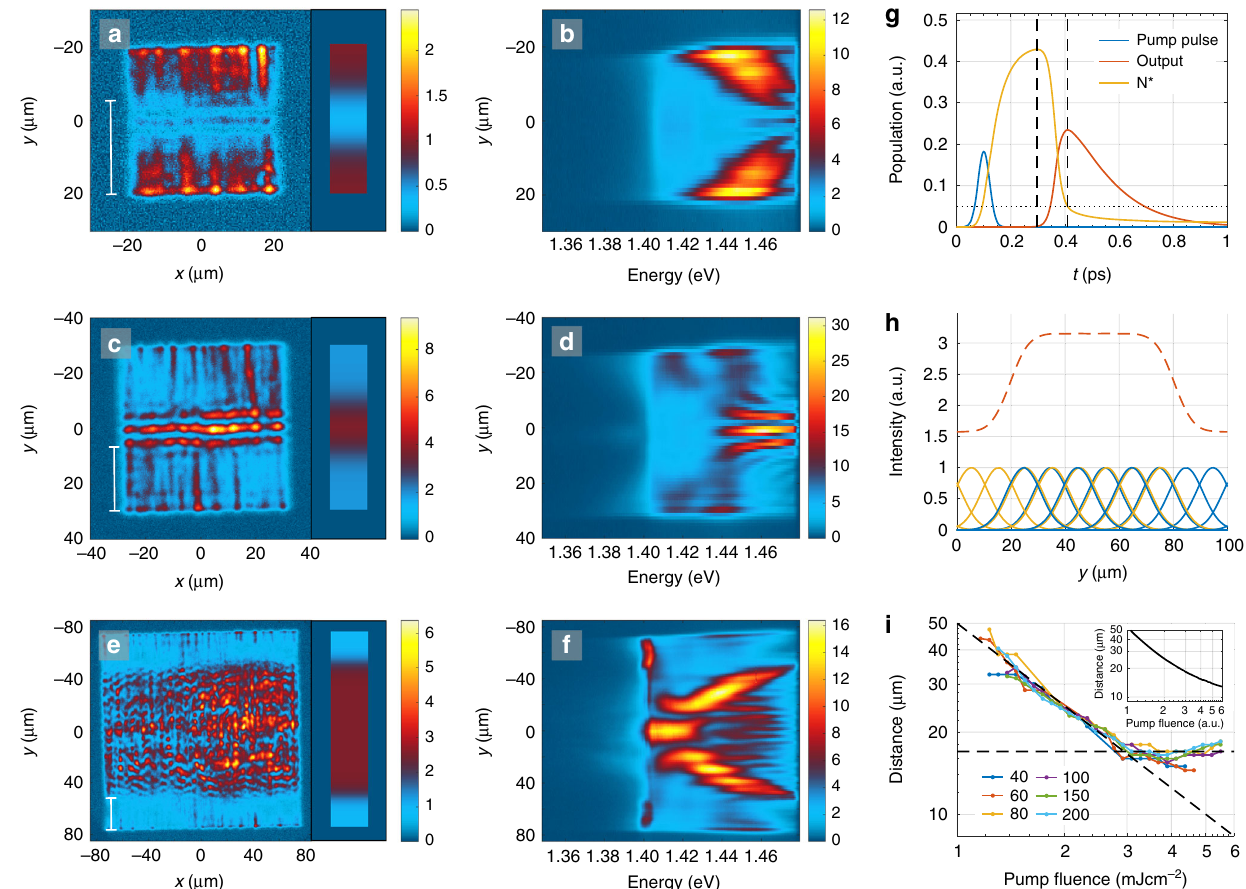
Fig. 5 Observation of stimulated emission pulse build-up in fi nite size lattices. a – f Real space images (left column) and spectra (middle column) at intermediate pump fl uence (2.2 mJ cm − 2 ) for lattice sizes a , b 40 × 40 μ m 2 , c , d 60 × 60 μ m 2 , e , f 150 × 150 μ m 2 . Please note the different color scales in different panels. Line spectra for the different lattice sizes are presented in Supplementary Fig. 11. g Rate-equation simulation of stimulated emission. The pulse build-up time relevant for our system is marked by vertical dashed lines (the peaks of the population inversion N * and of the output pulse). Horizontal dotted line indicates the value at which N * overcomes the losses in the simulation. h Illustration of the sum (red dashed line) of spatial intensity pro fi les of the thermalizing pulses propagating to left (yellow) and right (blue) starting from everywhere along the y -axis of the array. The Gaussian shape approximates the increasing and decreasing intensity of the excitations as they gather gain and suffer losses under propagation. The results of such sum for different array sizes are shown as insets in a , c , e with the same false color as the real space images. i Measured distance from the array edge to the location where the red shift begins (indicated by the 25 μ m scale bars in a , c , e ) as a function of pump fl uence for different lattice sizes. The legend indicates the square-array sizes in μ m. The diagonal dashed line is the inverse of the pump fl uence (50/ P ), and the horizontal dashed line indicates the saturation value (~18 μ m). The inset shows the pulse build-up time (converted to distance by multiplying with the group velocity of the SLR mode) obtained from the rate-equation